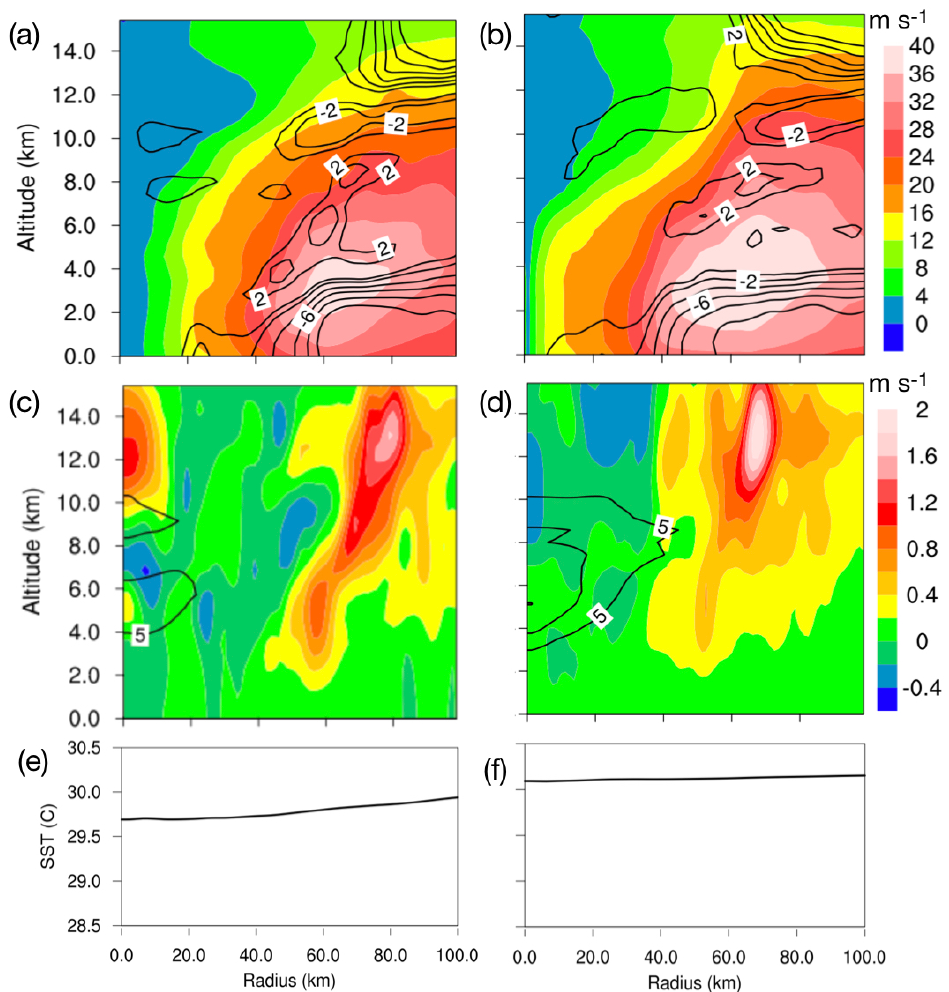
Figure 8. Same with Figure 7 but at 1700 UTC on 22